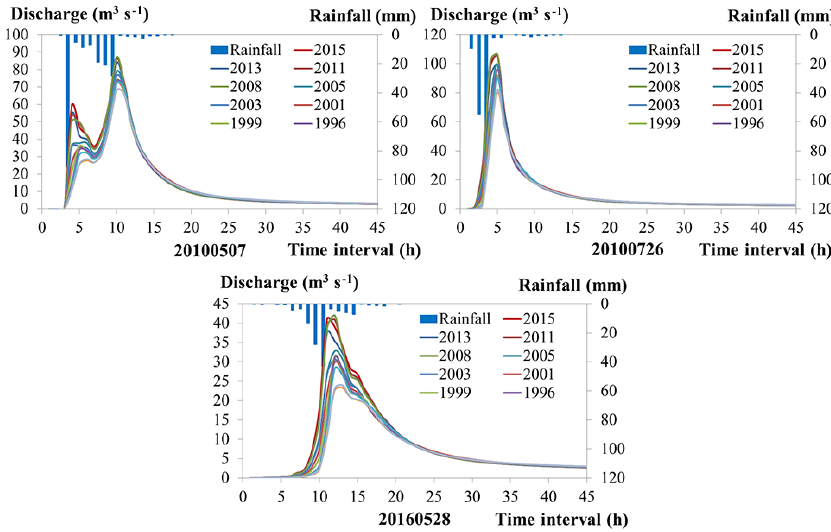
Figure 6. 3 of the simulated flood